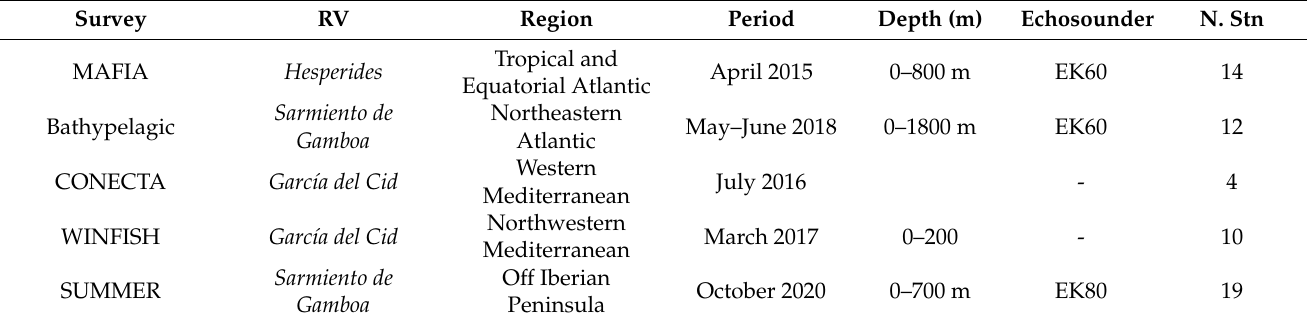
Table 1. Acronyms of projects and surveys (Survey). Research vessels (RV). Geographical limits of the survey (Region). Month and year of the survey (Period). Vertical sampling ranges (Depth). Type of acoustic equipment (Echosounder). Number of stations sampled with the system (N.